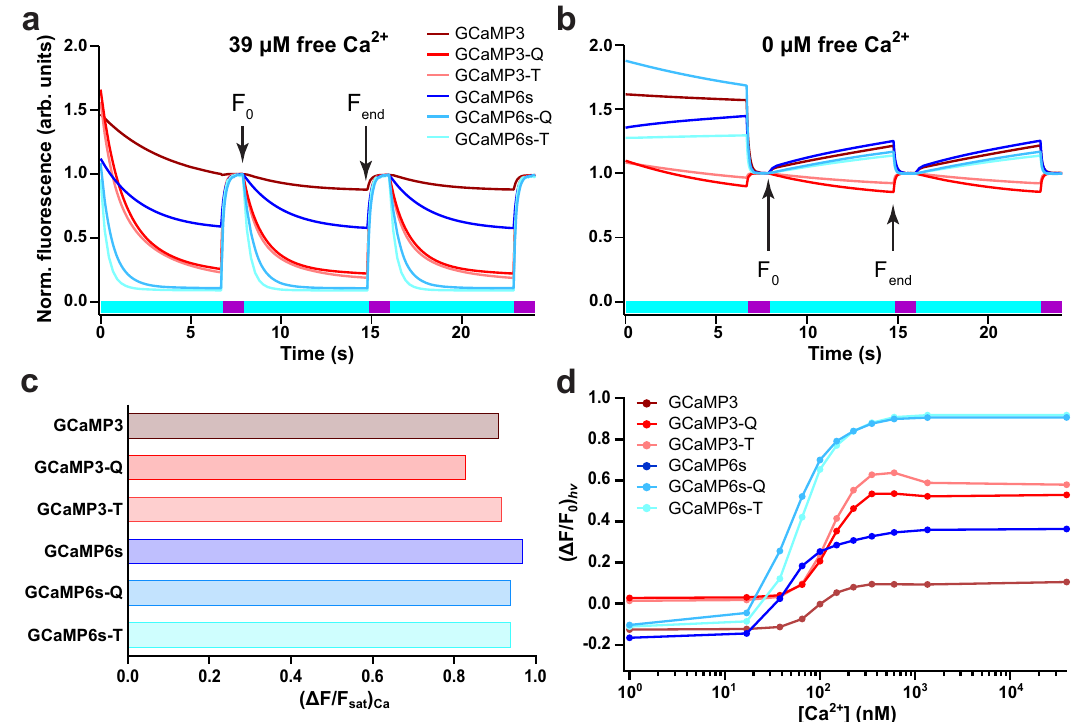
Fig. 1 In vitro dependence of the sensor fl uorescence on light illumination and Ca 2 + levels. a , b Cyan- and violet-light-induced photochromism in puri fi ed proteins in the presence ( a ) and absence ( b ) of free Ca 2 + . The cyan and violet bars at the bottom of the plots show the sequence of the illumination. F 0 and F ð Δ F = F Þ values. c Difference in the observed fl uorescence between Ca 2 + -saturated ( sat ) end refer to the intensities that would be used to calculate the 0 hv and Ca 2 + -free conditions ( apo ), normalized by the fl uorescence of the sat -form, as measured in bacterial cell lysates. d Photochromism contrast ð Δ F = F 0 Þ (cid:1) (cid:3) as a function of Ca 2 þ